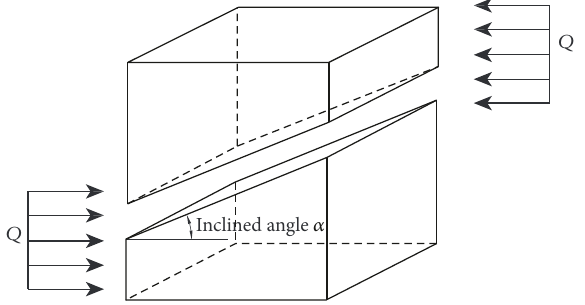
Figure 4: Cube specimen cutting at an inclination angle 𝛼